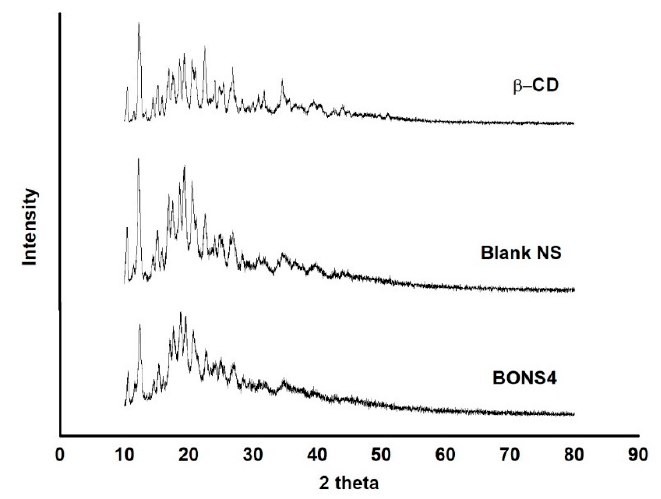
Figure 7. XRPD patterns of β -CD, blank NS, and BONS4.